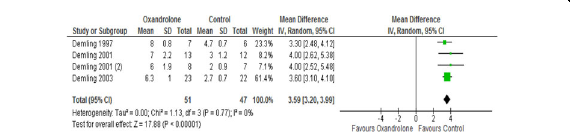
Fig. 2 (abstract 000169). Forest plot of the gain of weight in the rehabilitation